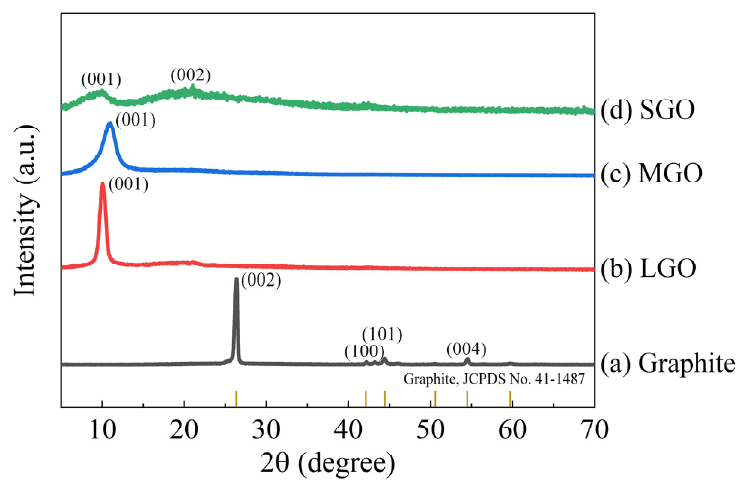
Figure 2. X-ray diffraction (XRD) patterns of ( a ) graphite, ( b ) LGO, ( c ) MGO, and ( d ) SGO.